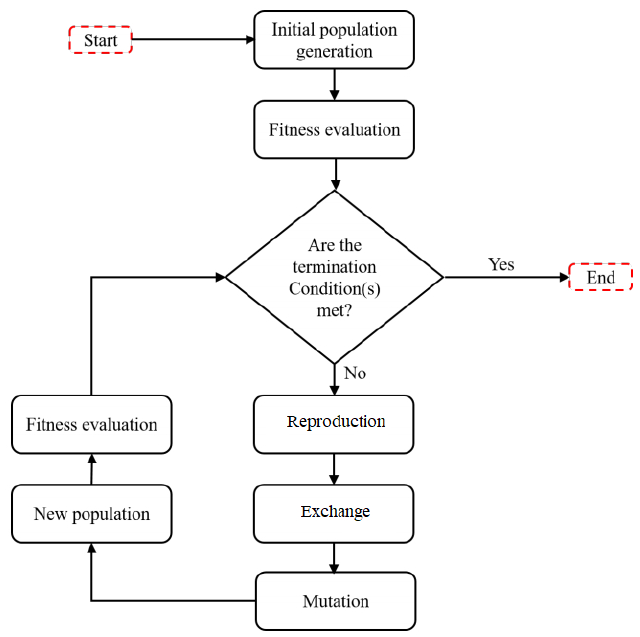
Figure 1. Genetic algorithm flowchart. Each subpopulation evolves according to the